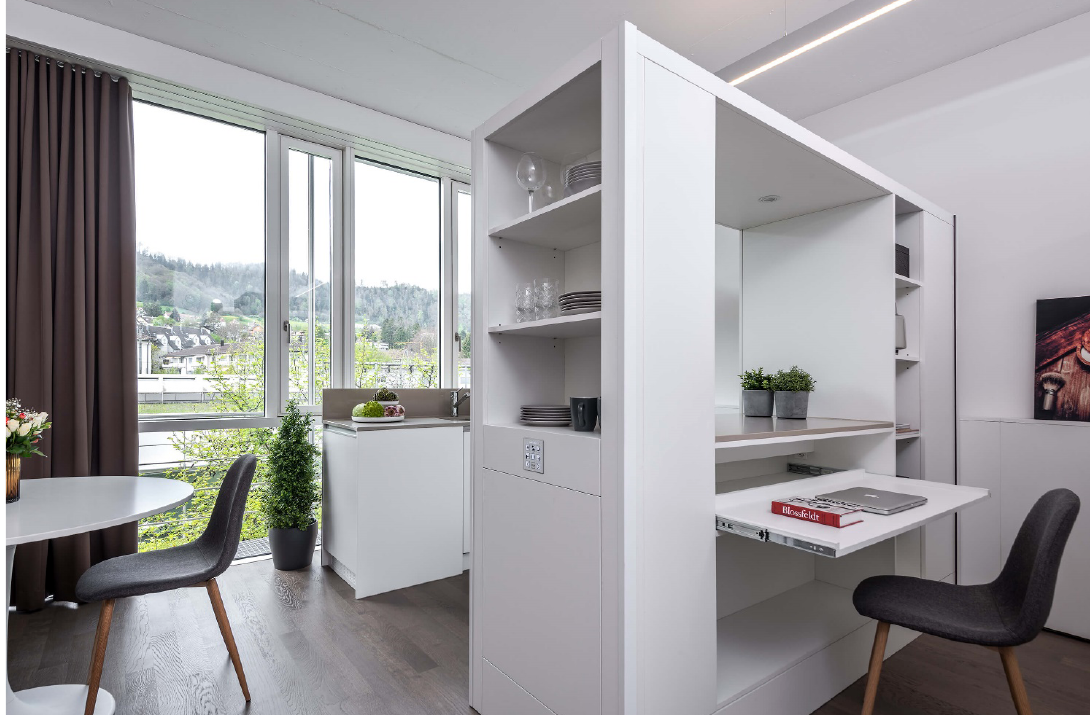
Figure 10. Halter, flexible MOVEment system, removable furniture in the living room-kitchen. Image courtesy of Halter. Urban Planning, 2019, Volume 4, Issue 3, Pages